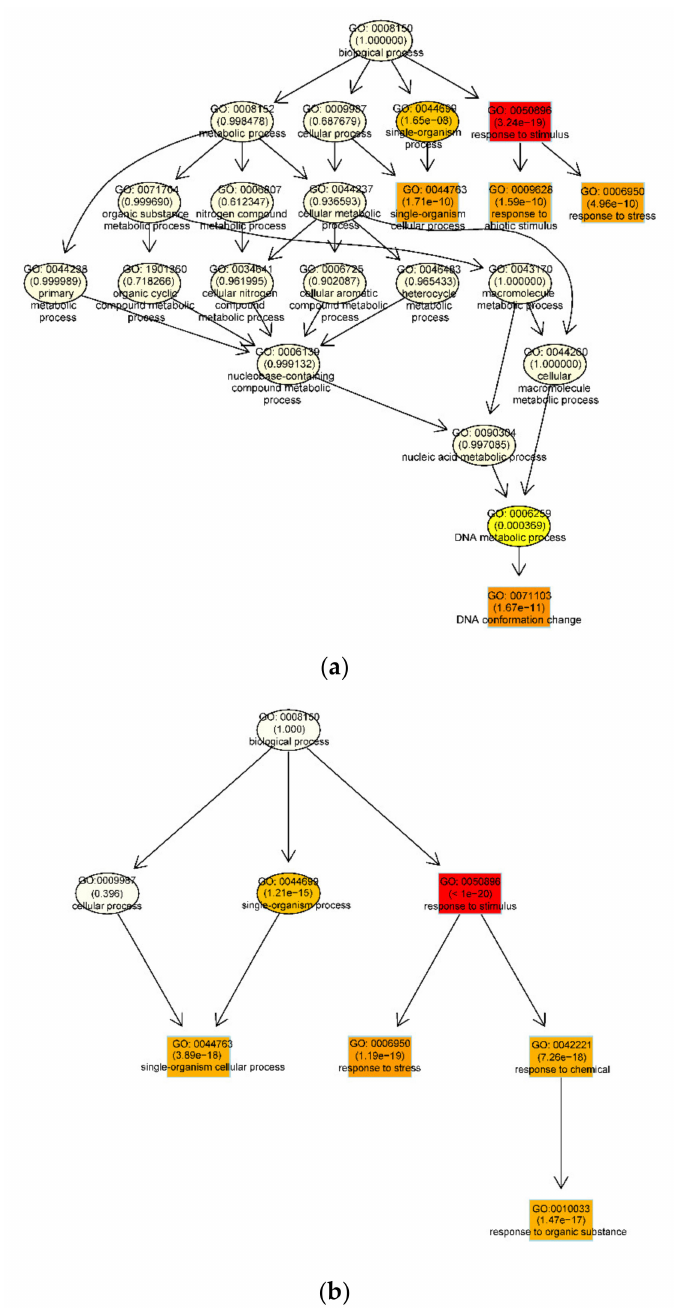
Figure 3. Functional GO enrichment analysis of di ff erentially expressed genes (DEGs) during embryogenic transdi ff erentiation in the two cotton genotypes. ( a ) GO enrichment of DEGs in LM_PEC- VS-LM_NEC; ( b ) GO enrichment of DEGs in YZ_PEC-VS-YZ_NEC. The biological processes with a false-discovery rate adjusted p -value < 0.05 are shown. GO, Gene Ontology. Each node represents a GO term, and the boxes represent the top five GO terms. The color depth represents the enrichment degree. The redder the color, the higher the enrichment degree, the more yellow the color, the lower the enrichment degree. The name of the GO term and the adjusted p -value of enrichment analysis are shown on each